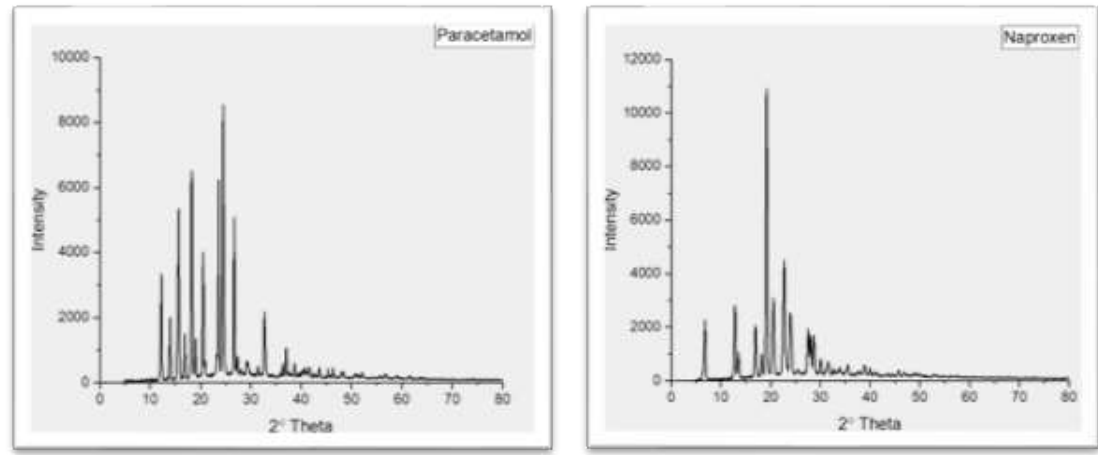
Figure 12.X-ray powder diffraction pattern of pure paracetamol and pure naproxen. The (1:1) paracetamol-naproxen co-crystal (N1) exhibited a completely different XRD